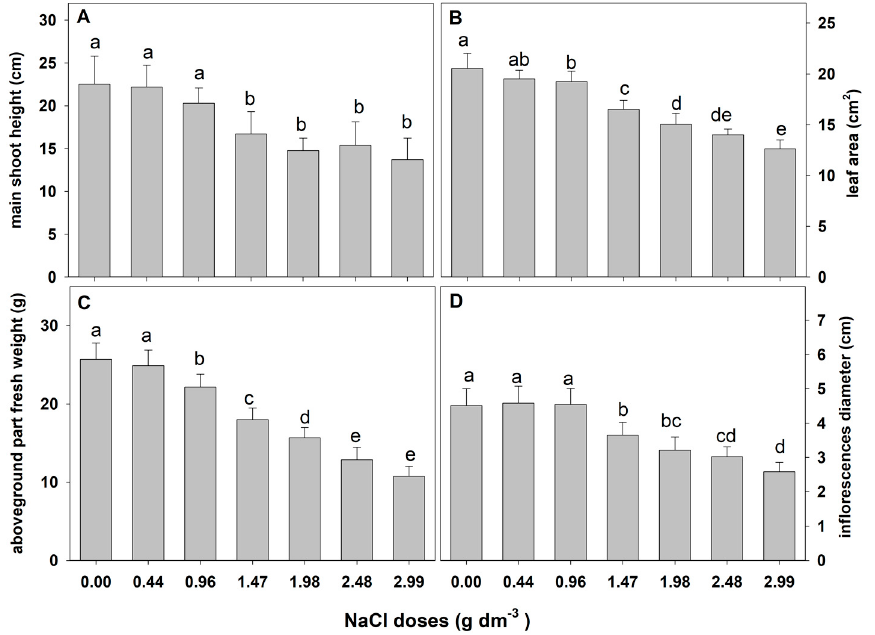
Figure 1. The effect of salinity doses on growth parameters in zinnia. Different letters show statistically significant differences between means. Values are expressed as the means (n = 15) ± standard deviation.